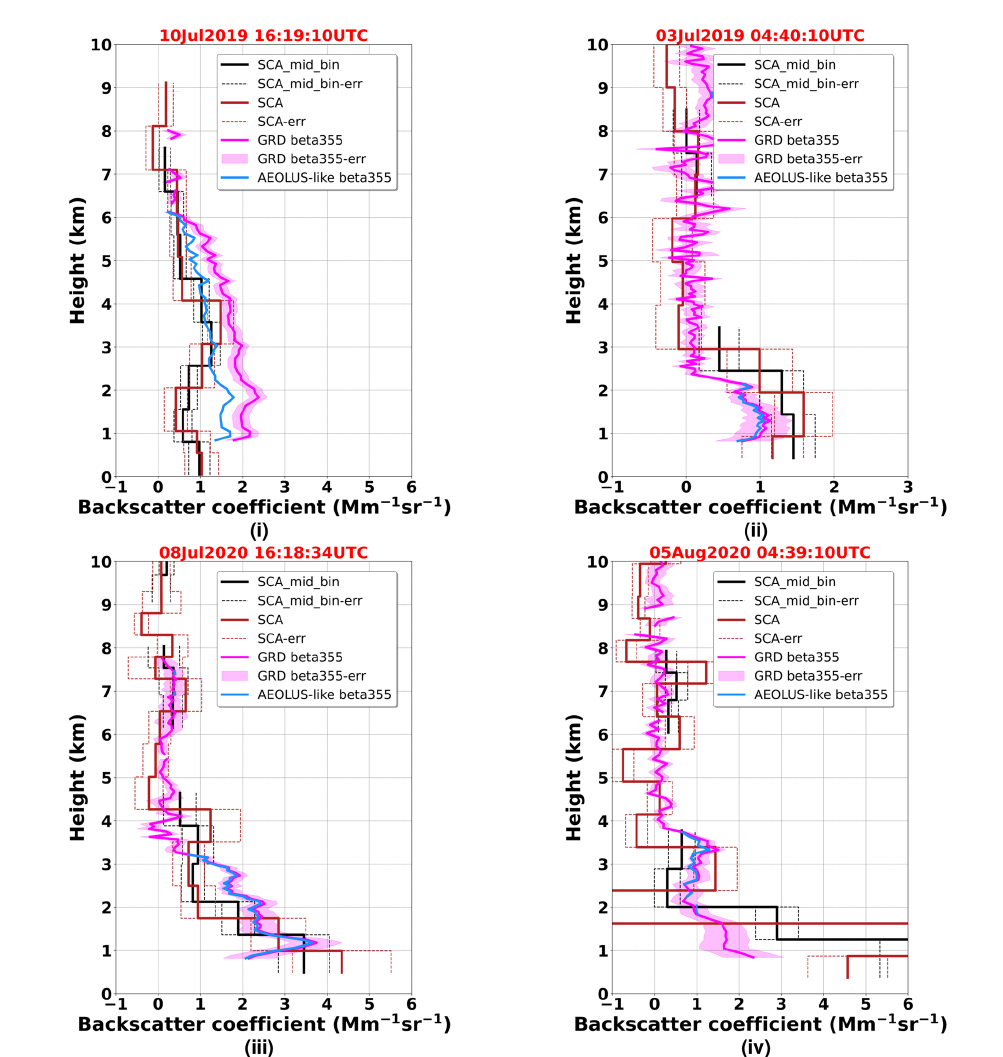
Figure 3. Vertical profiles of backscatter coefficient at 355nm acquired by ALADIN for the Level-2A SCA (regular vertical observation grid; brown solid curve) and SCA mid-bin (reduced vertical observation grid; solid black curve) products. The dashed lines correspond to the estimated SCA backscatter coefficient errors (brown) and SCA mid-bin backscatter coefficient errors (black). A vertical profile of Polly XT backscatter coefficient (solid pink curve) at the UV wavelength (355nm) and associated errors (shaded pink area) is shown. The Polly XT Aeolus-like backscatter coefficient (solid light blue curve) after converting the linear-derived products to circular co-polar, according to Paschou et al. (2022), is shown. The ground-based profiles have been acquired at the ANT station (southwestern Greece) on (i) 10 July 2019, (ii) 3 July 2019, (iii) 8 July 2020 and (iv) 5 August 2020. The red coloured font denotes which Aeolus BRC (along with the overpass time) has been selected, based on the defined collocation